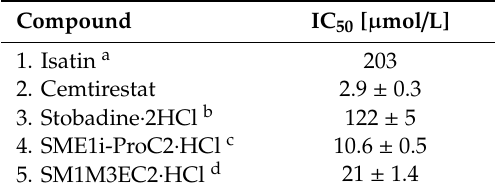
Table 3. Values of IC 50 determined by DPPH assay.